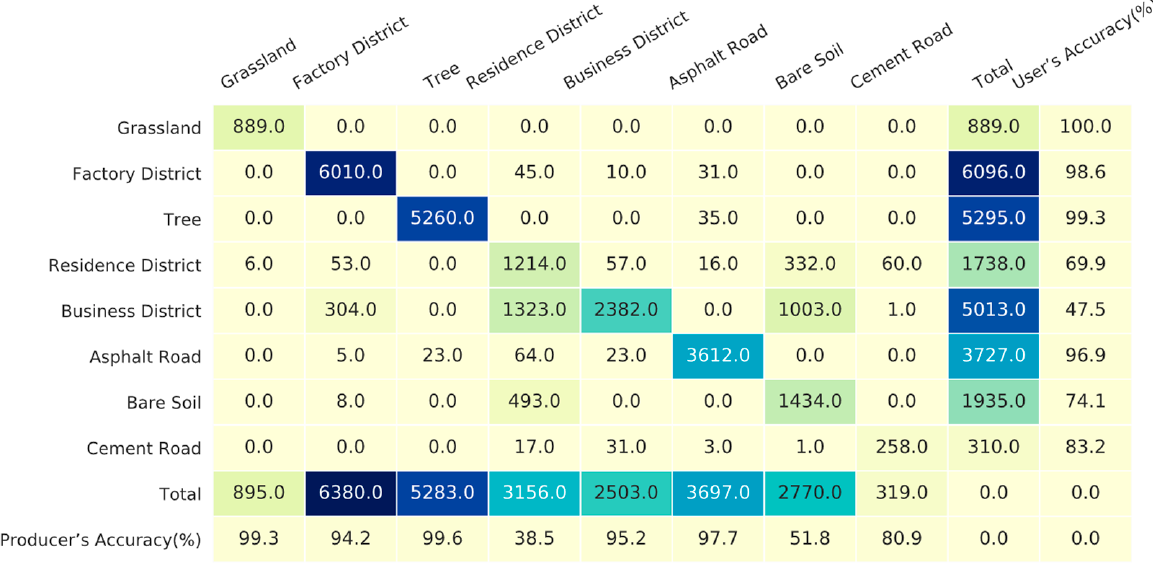
10 times with randomly selected angles and calculated the average percentages when